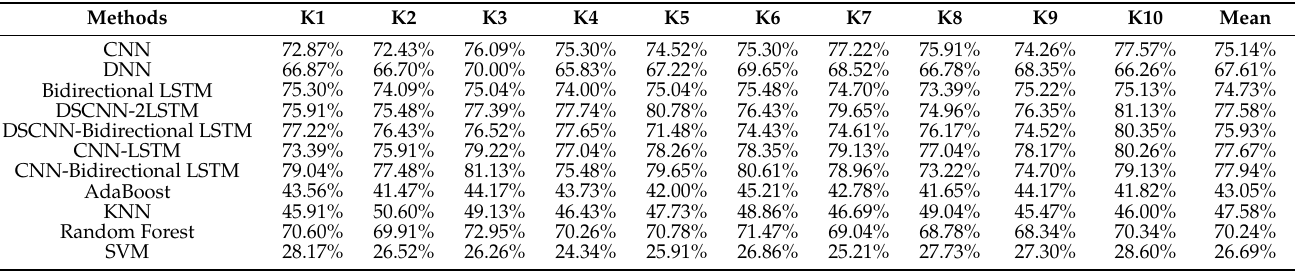
Table 12. The Performance of 11 models using 10-fold cross-validation on the five-class classifica- tion